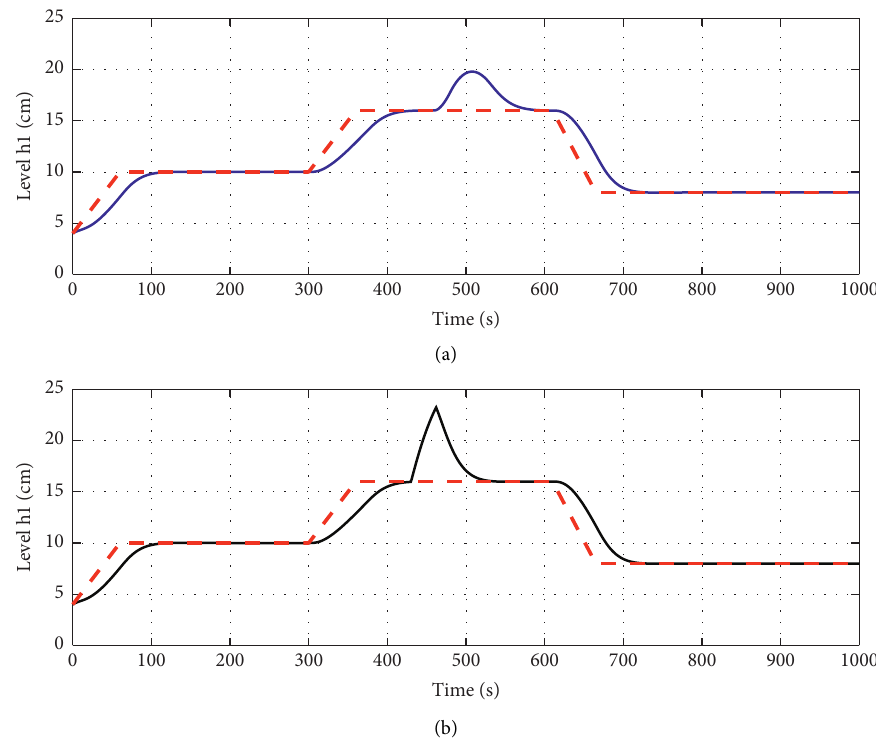
Figure 4: BC tracking result and its impact on disturbances. (a) With impact of the external disturbance; (b) with impact of the parameter variation.